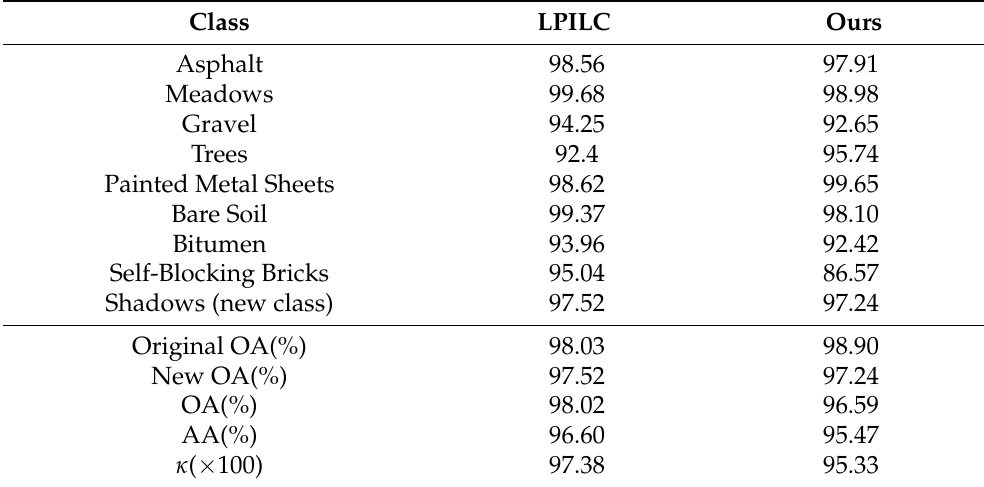
Table 3. Classification results of each class in the case of adding a new